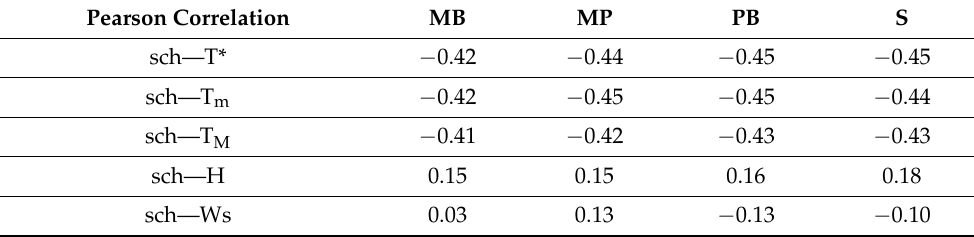
Table 7. Pearson correlation coefficient between snow cover height (sch), mean (T*), minimum (T m ), and maximum (T M ) temperature, relative humidity (H), and wind speed (Ws) at the weather stations (MB, MP, PB,